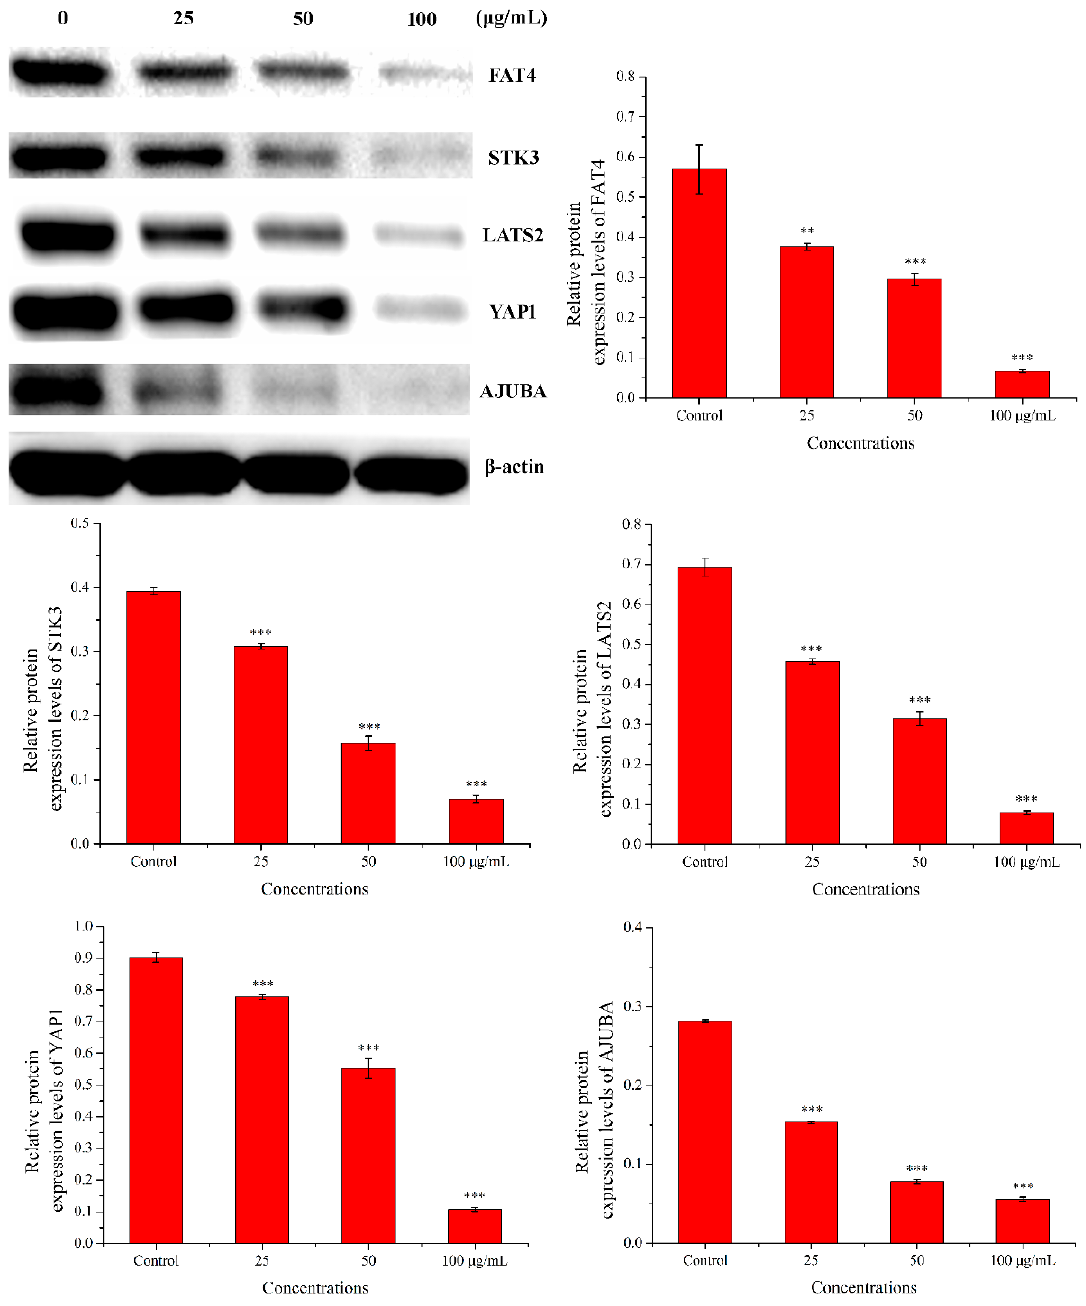
Figure 11. Results of western blot. MGC-803 cells were treated with 0, 25, 50, and 100 µg/mL PEO for 24 h ( n = 3, ** p < 0.01; *** p < 0.001).